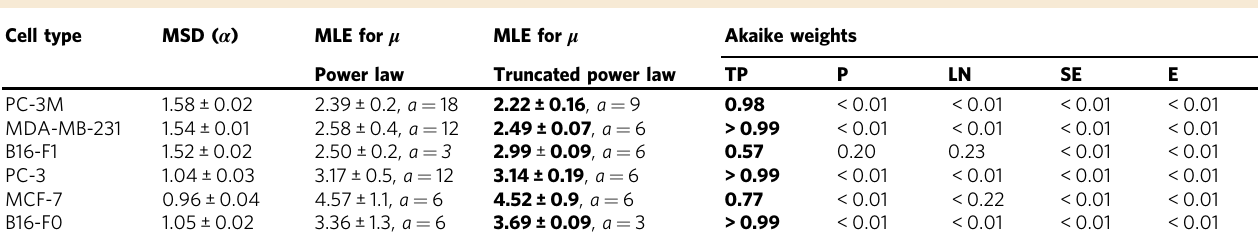
Table 1 Statistical analysis of cancer cell movements on 1D microtracks